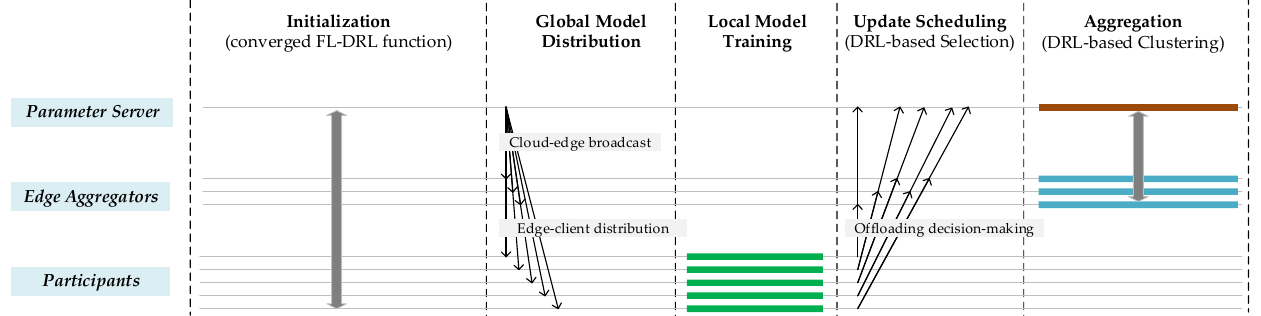
Figure 10. eFL procedures for the aggregation for the averaged global model.